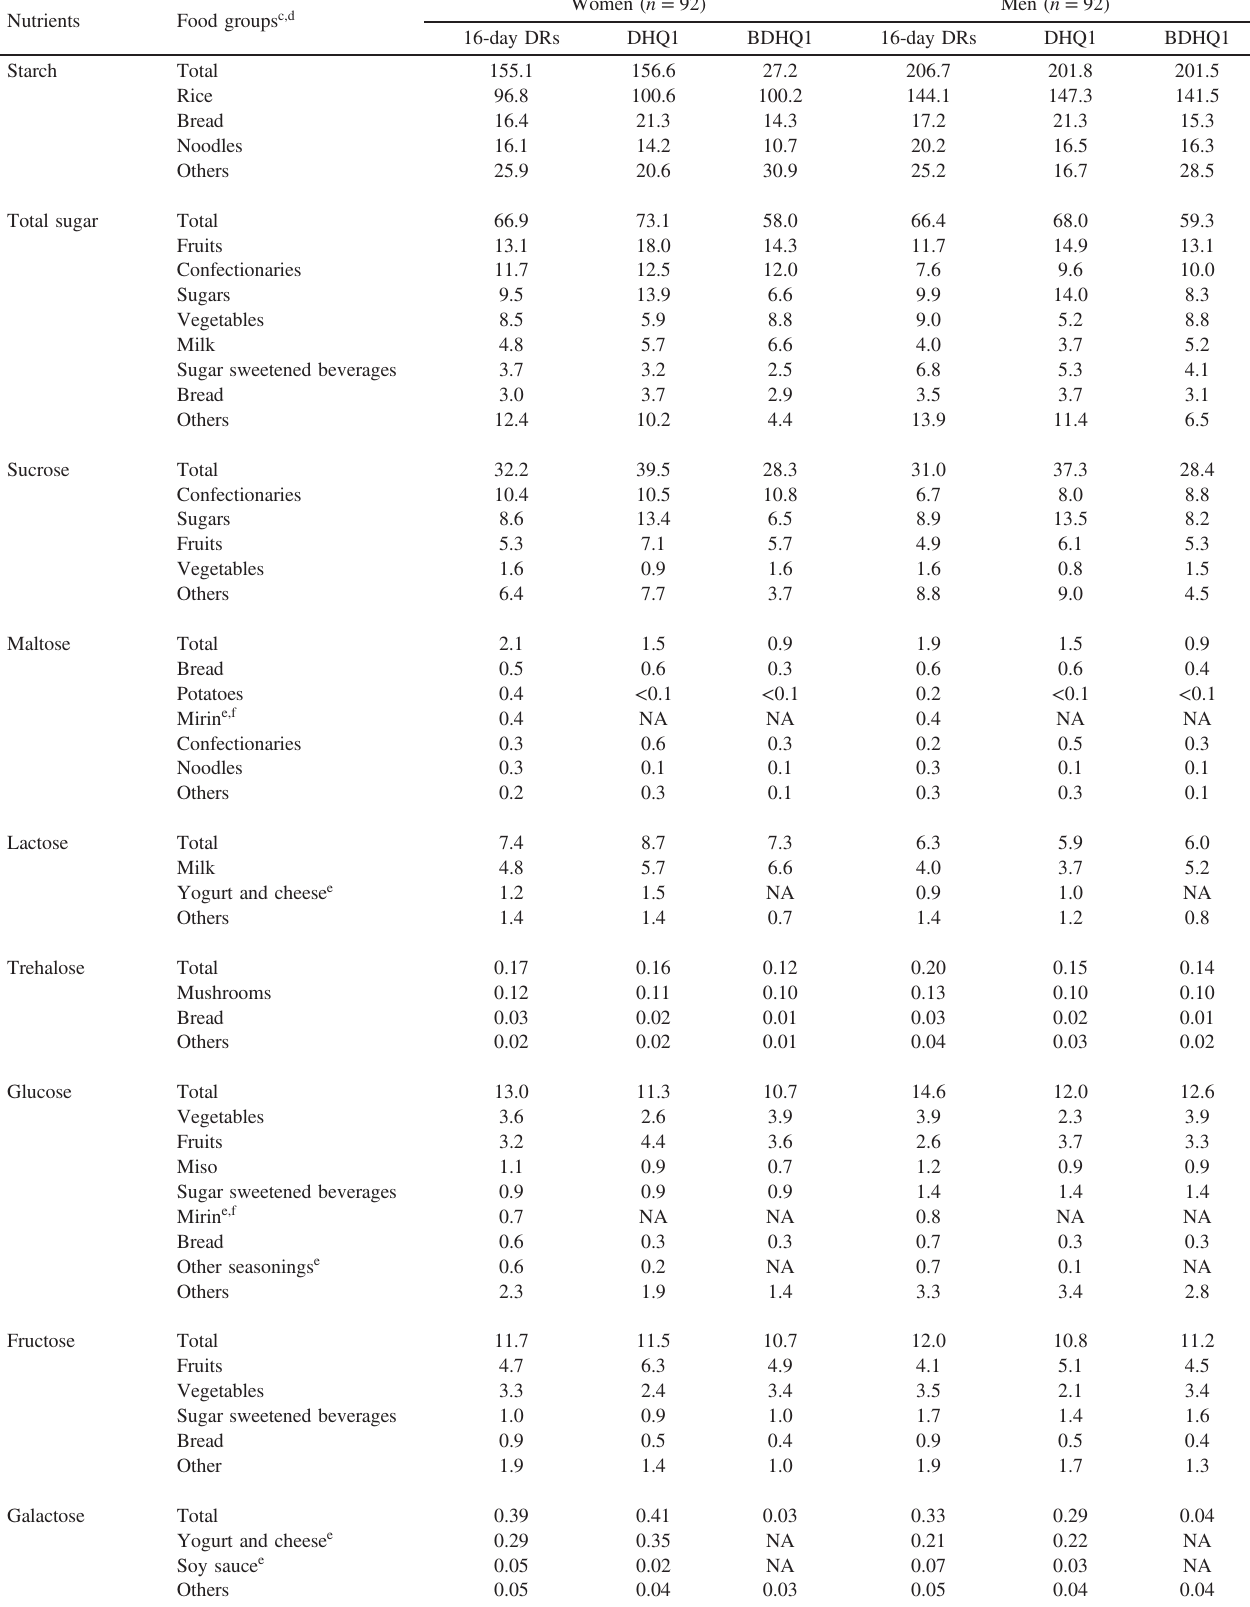
Table 6. Mean intake of starch and 10 types of sugars from each food group (g / d) estimated using the 16-day DRs, DHQ1, and BDHQ1 among Japanese women and men a,b Women ( n = 92) Men ( n = 92) Nutrients Food groups c,d Starch Total